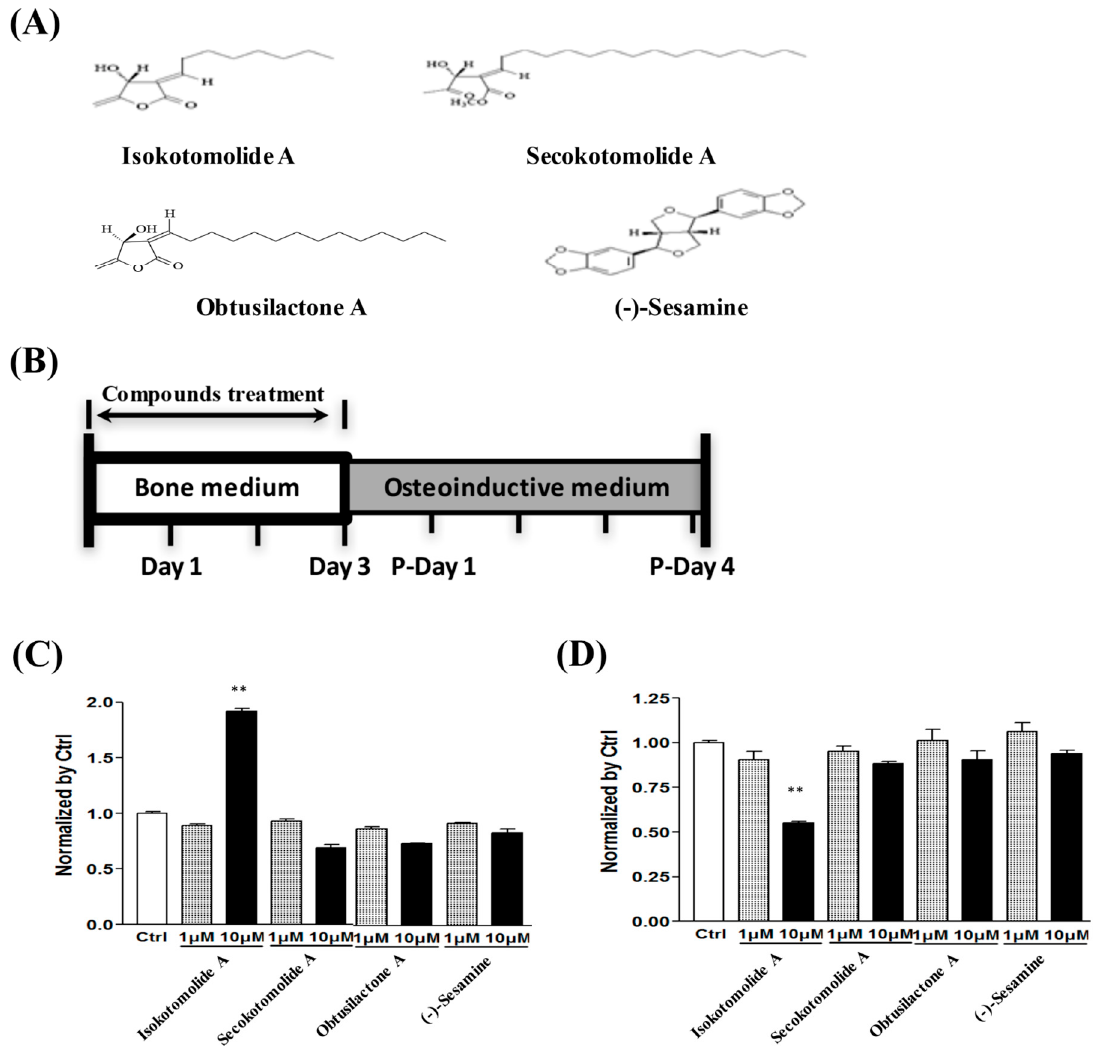
Figure 1. Determining the cytotoxic effects of pure compounds on BMSCs: ( A ) structures of the extracted pure compounds from the leaves of Cinnamomum kotoense ; ( B ) treatment time-line for analyzing the osteoinductive effects of extracted pure compounds from C. kotoense on BMSCs, P-Day: day post OIM replacement; ( C ) cytotoxicity analysis of BMSCs after treatment with 0.01% DMSO as a control group or a variety of pure compounds at concentrations of 1 µ M and 10 µ M for one day via LDH assays; and ( D ) MTT assays were used to determine cell viability after treatment with pure compounds extracted from C. kotoense for three days. ** p <0.01